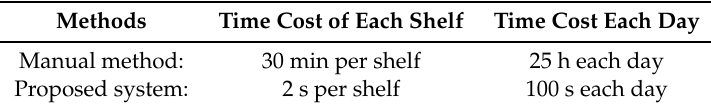
Table 3. Comparison of grouping